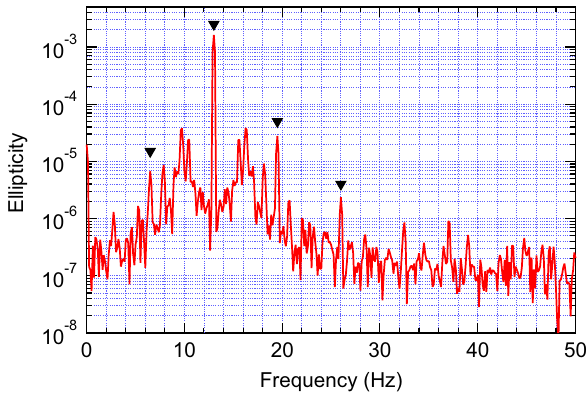
Fig. 5 A typical demodulated ellipticity spectrum of the optical zero- wave GP rotating at ν P = 6 . 5 Hz. The black triangles mark the first four harmonics of this frequency. A Hanning window and an 8 s integration time have been used; effective time due to the windowing is 5.3